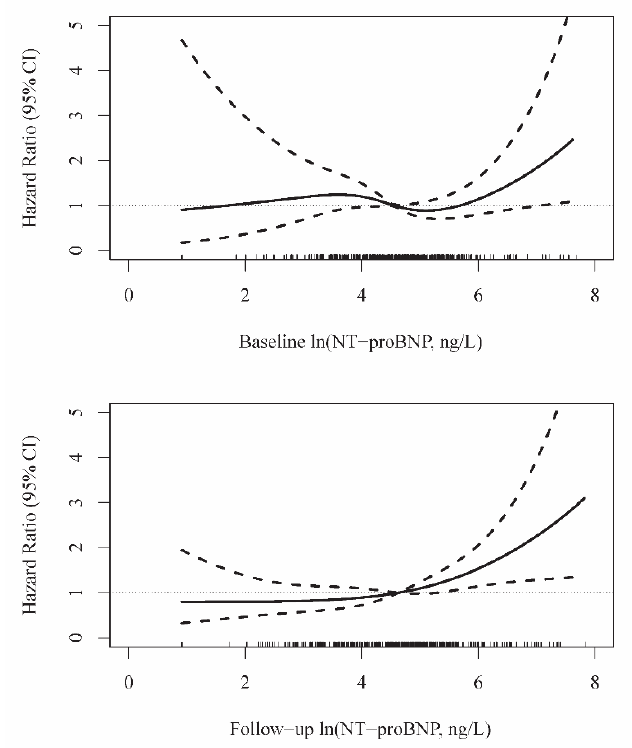
Figure 2. Relationship between NT-proBNP levels measured one year apart and mortality. Spline curves are adjusted for age, sex, BMI, current smoking, history of heart failure and diabetes mellitus, and baseline ln(hs-cTnT) (Table 3, Model 4).